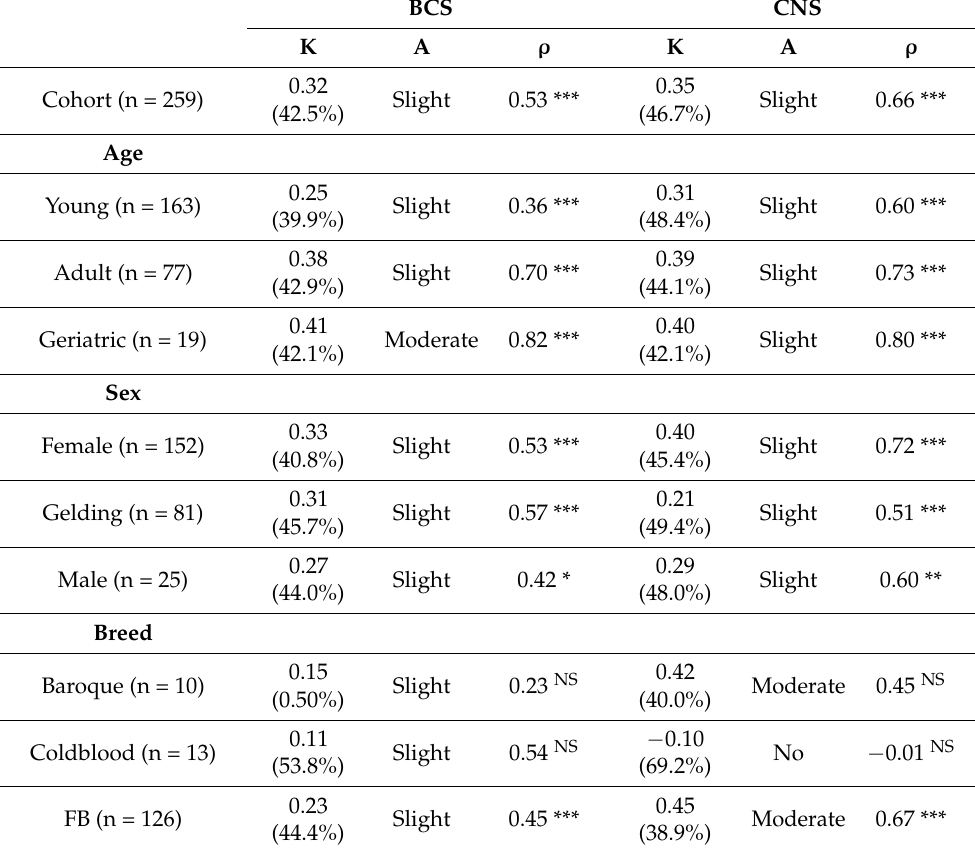
Table 2. Cohen’s kappa (K) coefficient (% of discordant cases), degree of agreement (A), and Spearman rank correlation ( ρ ) calculated for BCS and CNS on the cohort of horses included and according to age, sex, breed, and type of activity. Legend: BCS: Body Condition Score; CSN: Cresty Neck Score.; No: values ≤ 0 indicated no agreement; Slight: values between 0.01 and 0.40 indicate slight agreement; Moderate: values between 0.41 and 0.60 indicate moderate agreement; Optimal: values between 0.81 and 1.00 indicate optimal agreement; NE: not evaluable. *: p -value between 0.05 and 0.01; **: p -value between 0.01 and 0.001; ***: p -value < 0.001; NS: not significant. BCS BCS CNS